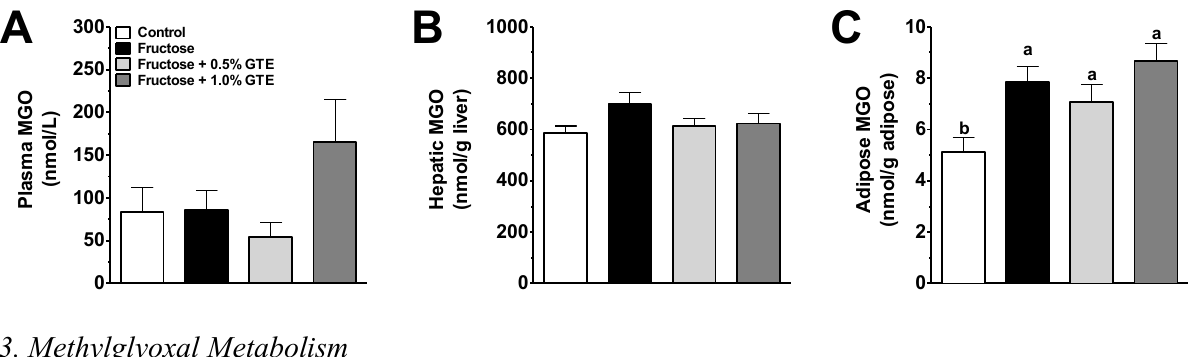
Figure 2. ( a ) MGO concentrations in plasma. ( b ) MGO concentrations in liver. ( c ) MGO concentrations in adipose. MGO concentrations are shown from rats fed a starch-based control diet containing 50% (w/w) starch and 10% (w/w) fructose (Control), a high-fructose diet containing 60% fructose (Fructose), the fructose diet containing 0.5% green tea extract (GTE) (w/w) (Fructose + 0.5% GTE), or the fructose diet containing 1.0% GTE (Fructose + 1.0% GTE) for nine weeks (means ± SE; n = 8–9/group). Samples were acidified with PCA, derivitized with OPD, and analyzed by HPLC-UV. 1-Way ANOVA main effects are significant for adipose ( P < 0.01) but not plasma or liver ( P > 0.05). Group means without a common superscript are different ( P <